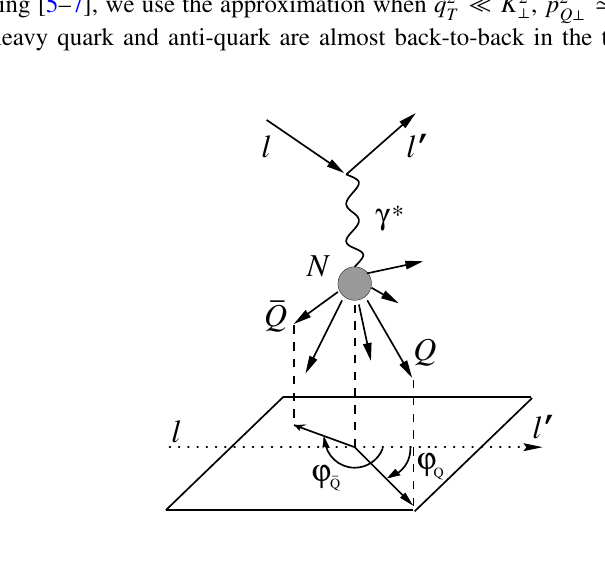
Q in the nucleon rest